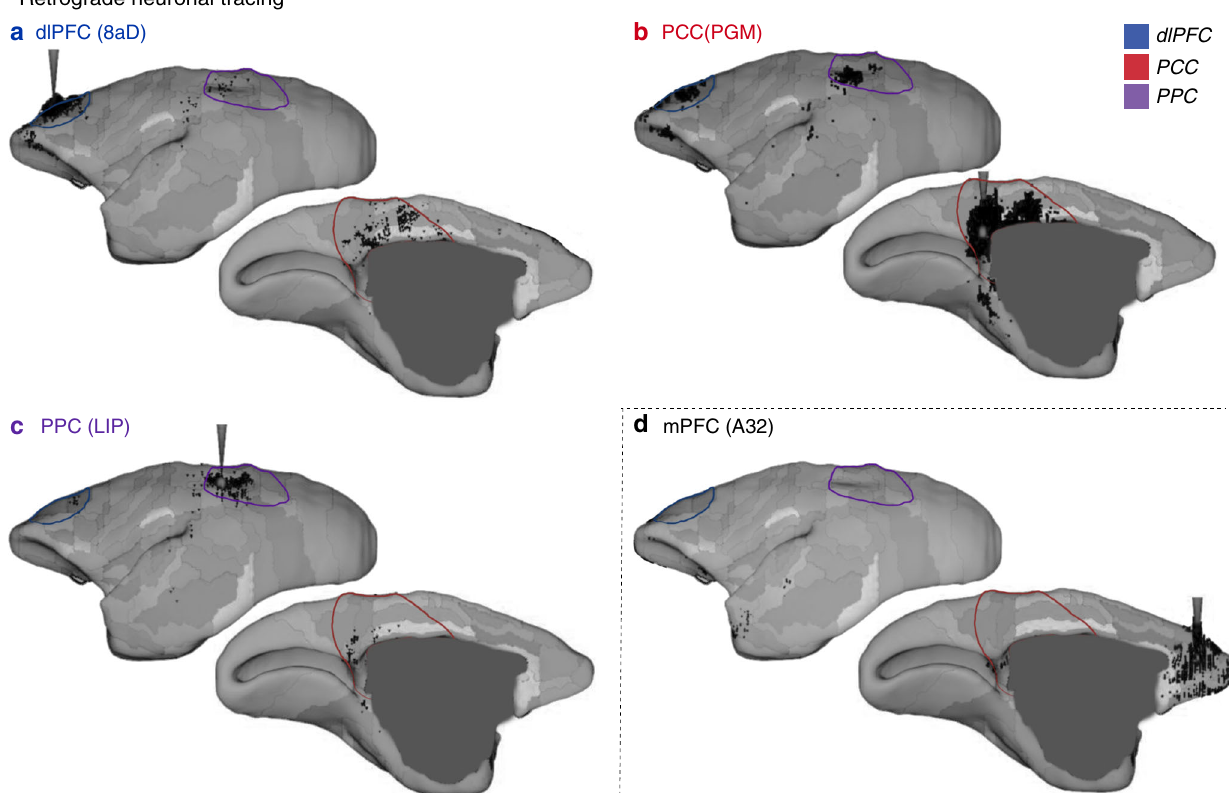
Fig. 4 DMN regions have direct anatomical connections with each other but not the mPFC. Retrograde tracing data are retrieved from the Monash Marmoset Brain Architecture Project 14 . Colored borders are manually overlaid on the tracing maps for visualization, which represent the approximate location and size of each of the three DMN regions as determined by ICA of resting-state fMRI data using a default threshold (Fig. 1a). The dlPFC is in blue, the PCC in red, and the PPC in purple. Injection cases of CJ108 ( a ), CJ84 ( b ), CJ55 ( c ), and CJ187( d ) are presented. More injection examples of related areas are presented in Supplementary Fig. 1. Note that areas A8aD, PGM, and LIP are terms that were de fi ned by the Paxinos parcellation 15 , which do not necessarily have a one-to-one homology with other species. dlPFC dorsal – lateral prefrontal cortex, PPC posterior parietal cortex, PCC posterior cingulate and medial parietal cortex, mPFC medial prefrontal cortex. Arrows identify the different regions according to the color